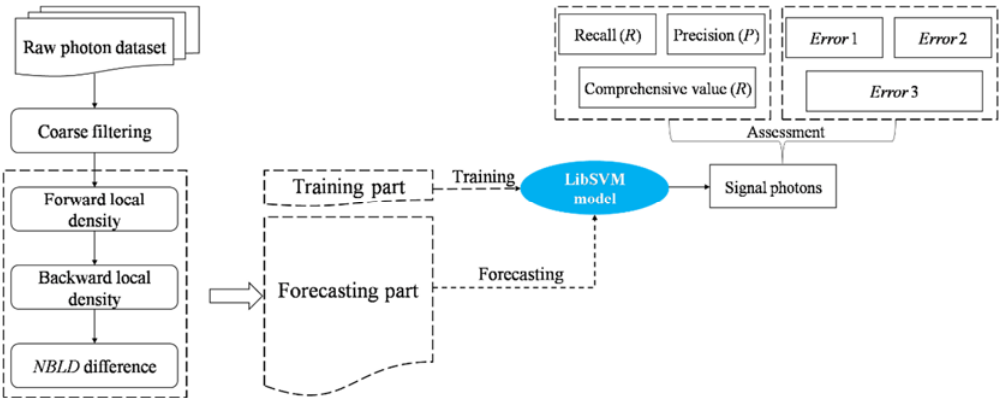
Figure 6. Flow chart of the proposed